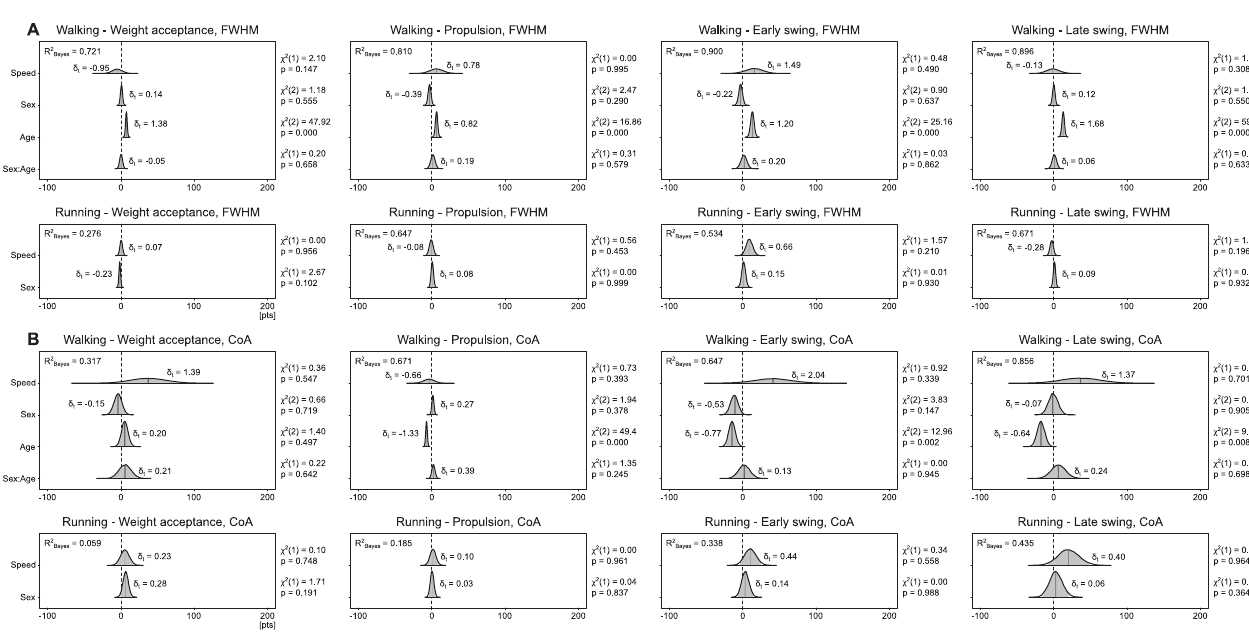
Fig 6. Posterior 95% credible intervals for the estimated differences in full width at half maximum and center of activity. (A) The 95% credible intervals and their probability distributions (shaded areas) describe the effects and interaction of sex and age (with locomotion speed as a covariate) on the full width at half maximum (FWHM). Positive values indicate wider primitives in females than in males and in older than in younger adults. Effect size in the style of Hedges (i.e., considering all the variance sources in the model) are shown on the graphs and called δ t . A Bayesian equivalent of R 2 (here R 2 Bayes ) describes how well the model fits the data. Next to each estimation, the χ 2 and p-values resulting from a frequentist linear mixed model analysis are reported as additional information. (B) The same as in panel (A), but for the center of activity (CoA).